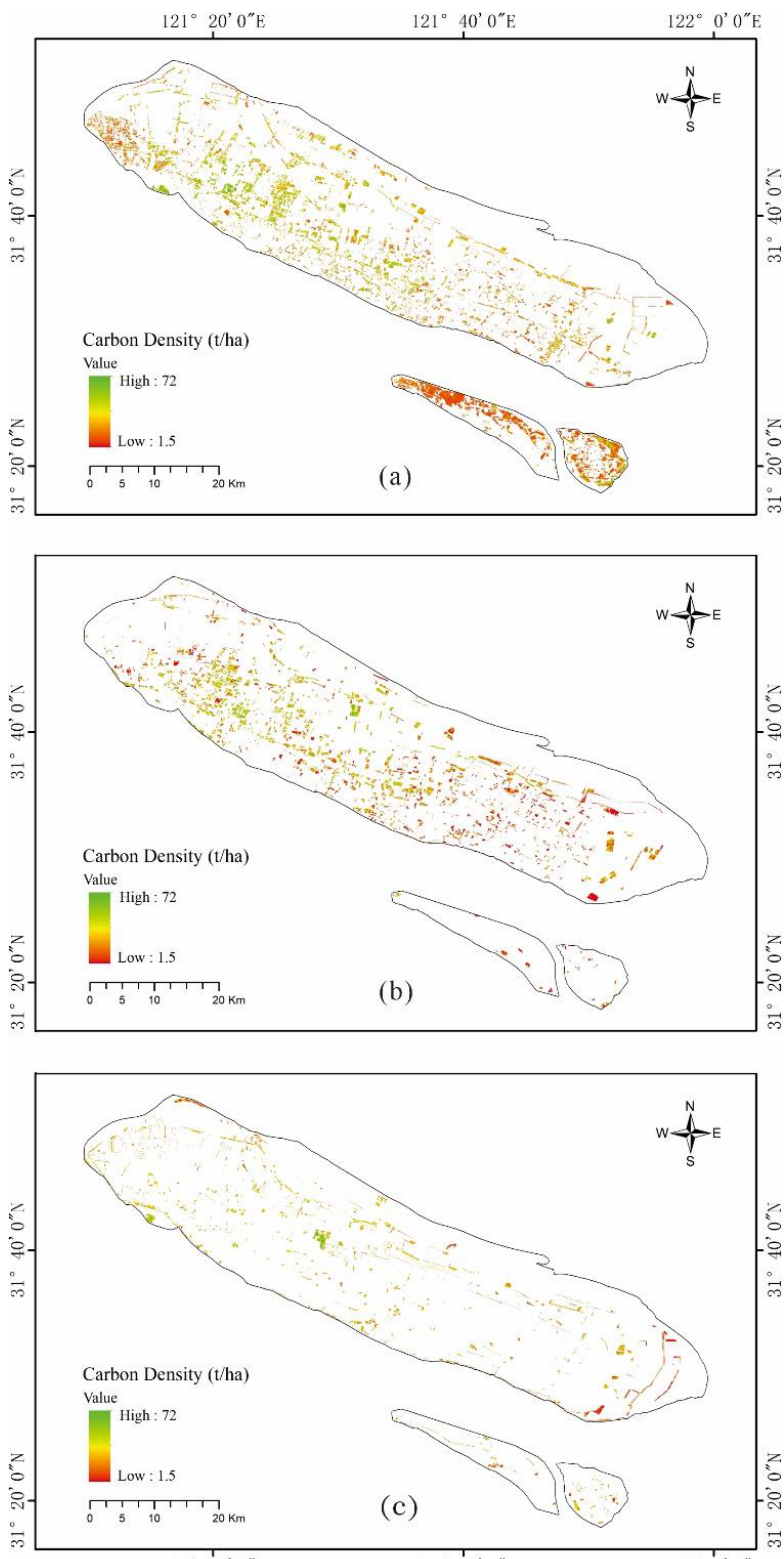
Figure 4. Spatial distribution of the forest carbon density on Chongming eco-island: ( a ) evergreen broad-leaved forests, ( b ) deciduous broad-leaved forests, and ( c ) warm coniferous forests.